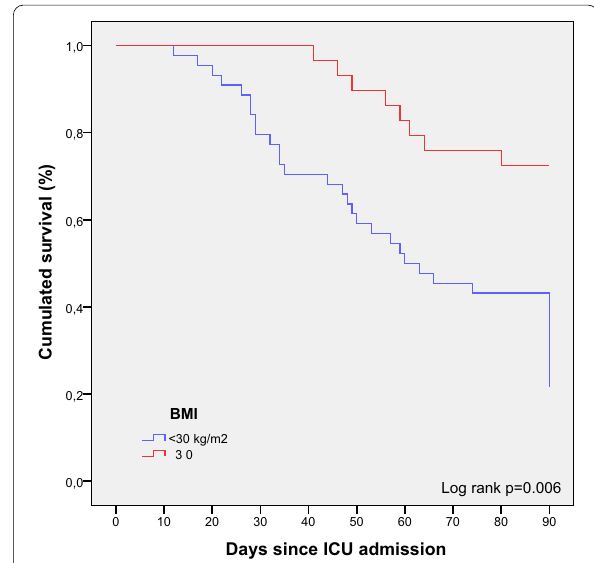
Fig. 1 Kaplan–Meier cumulated survival curves at day 90 since ICU admission in obese (red curve) and non‑obese patients (blue curve). Obesity was defined as a BMI 30 kg/m ≥